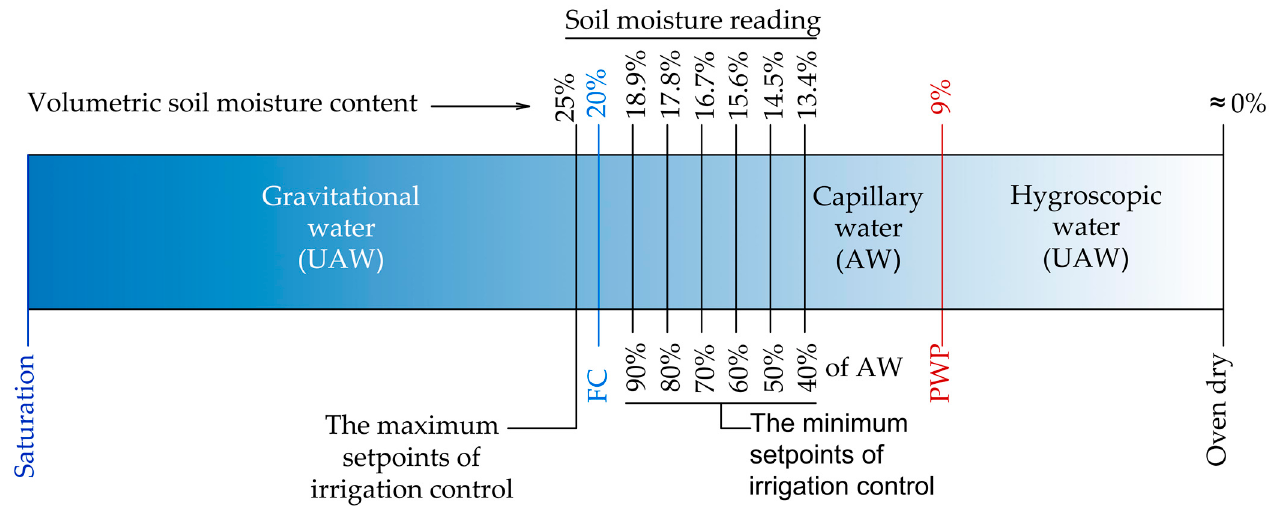
Figure 3. Water type, thresholds for soil in the study area, and minimum and maximum irrigation control setpoints. The FC, AW, PWP, and UAW denote field capacity, available water, permanent wilting point, and unavailable water.